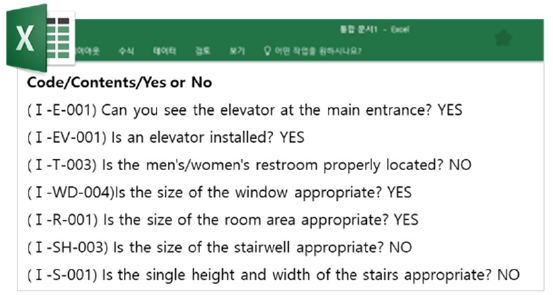
Figure 16. Results extracted to excel through reporting.